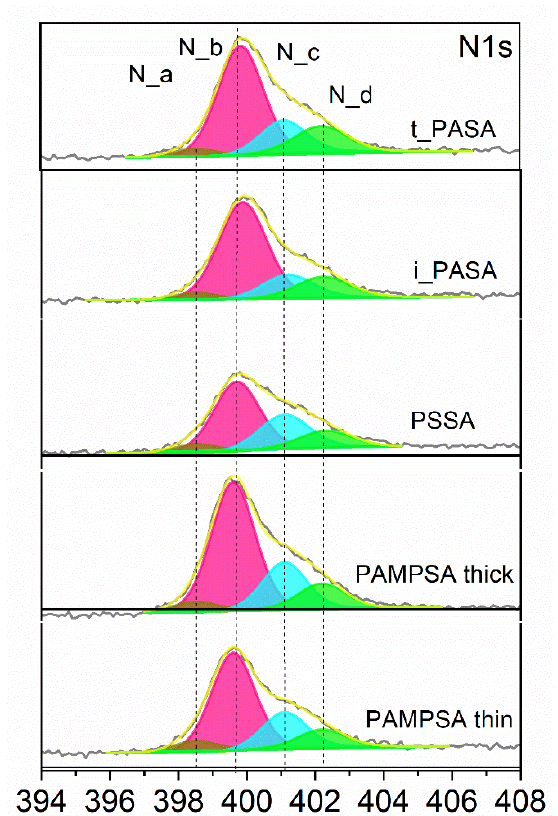
Figure 7. Deconvoluted N 1s spectra of the different PANI materials. Table 3. Data for the atomic content of nitrogen and sulfur and relative rations of N obtained from XPS studies and for the electrochemical redox number.